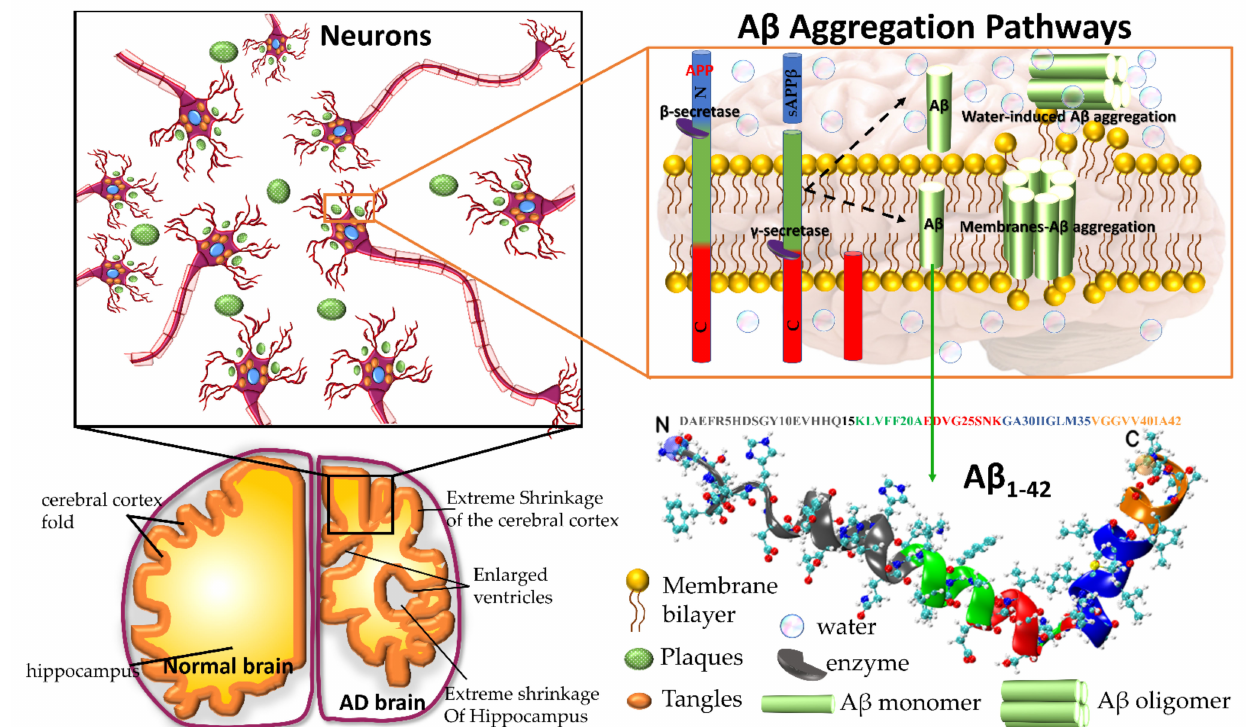
Figure 1. Plaques are around the neurons and tangles inside the neurons. Plaques and tangles are involved in killing the neurons resulting in drastic shrinking of the brain compared to normal brain. β -secretase cleaves APP (composed of 695 amino acids) into the membrane-tethered C-terminal fragments β (CTF β or C99) and N-terminal sAPP β . A β is obtained after the sequential cleavage of CTF β by γ -secretases. Upon APP cleavage, two mechanism pathways have been proposed, in the first, A β is released to the extracellular environment, due to its hydrophobic nature, formed A β aggregates, in the second, a small amount of A β remains in the membrane evolving into membrane-associated A β aggregates. A β peptide has divided into five regions, N-terminus or hydrophilic region represent in grey, Central hydrophobic region in green, Loop region in red, second hydrophobic region in blue and C-terminal in orange. AD brain shrunken as compared with Healthy